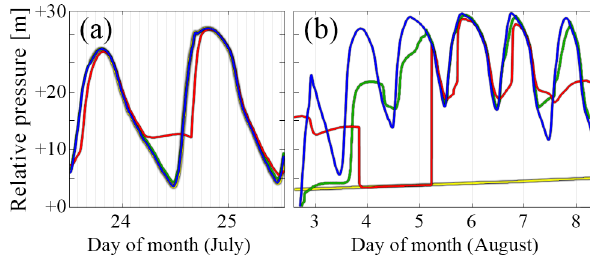
Figure 7. Pressure records from the four sensors marked S1–S4 in Fig. 6b in July (a) and August (b) 2014. Colour coding is red (S1), yellow (S2), green (S3), and blue (S4). We have applied a constant value offset in pressure to each time series (meaning, added a constant to the directly measured pressure) to make the agreement between the records clearer. The offset values are, in order, 27, 26, 24, and 29 metres in panel (a) , and 27, 20, 22, and 27 in panel (b) . Note that the S2–S4 time series in panel (a) agree so well with each other that they are barely